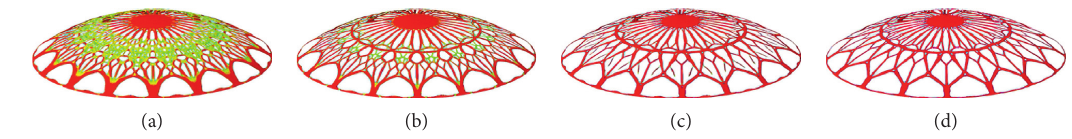
Figure 4: Optimization results of a spherical shell (isometric view). (a) 40 th iteration. (b) 60 th iteration. (c) 80 th iteration. (d) 95 th iteration.